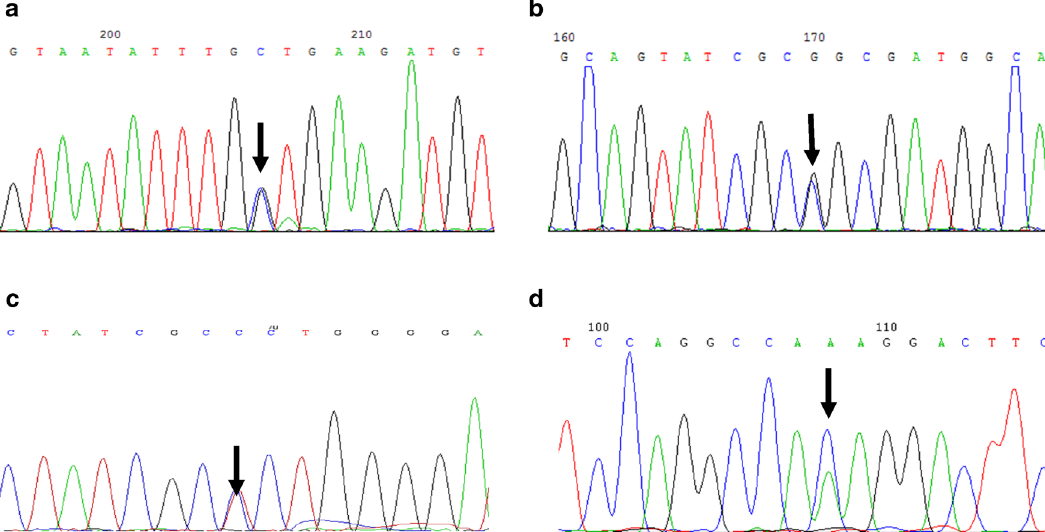
Figure 2. Gene sequences of four novel variants in BCKDHA and BCKDHB genes in eight pedigrees: c.841G>C(p.Gly281Arg) in BCKDHA gene ( a ), c.284G>C(p.Gly95Ala) in BCKDHB gene ( b ), c.511T>C(p. Ser171Pro) in BCKDHB gene ( c ), c.665A>C(p.Lys222Thr) in BCKDHB gene ( d